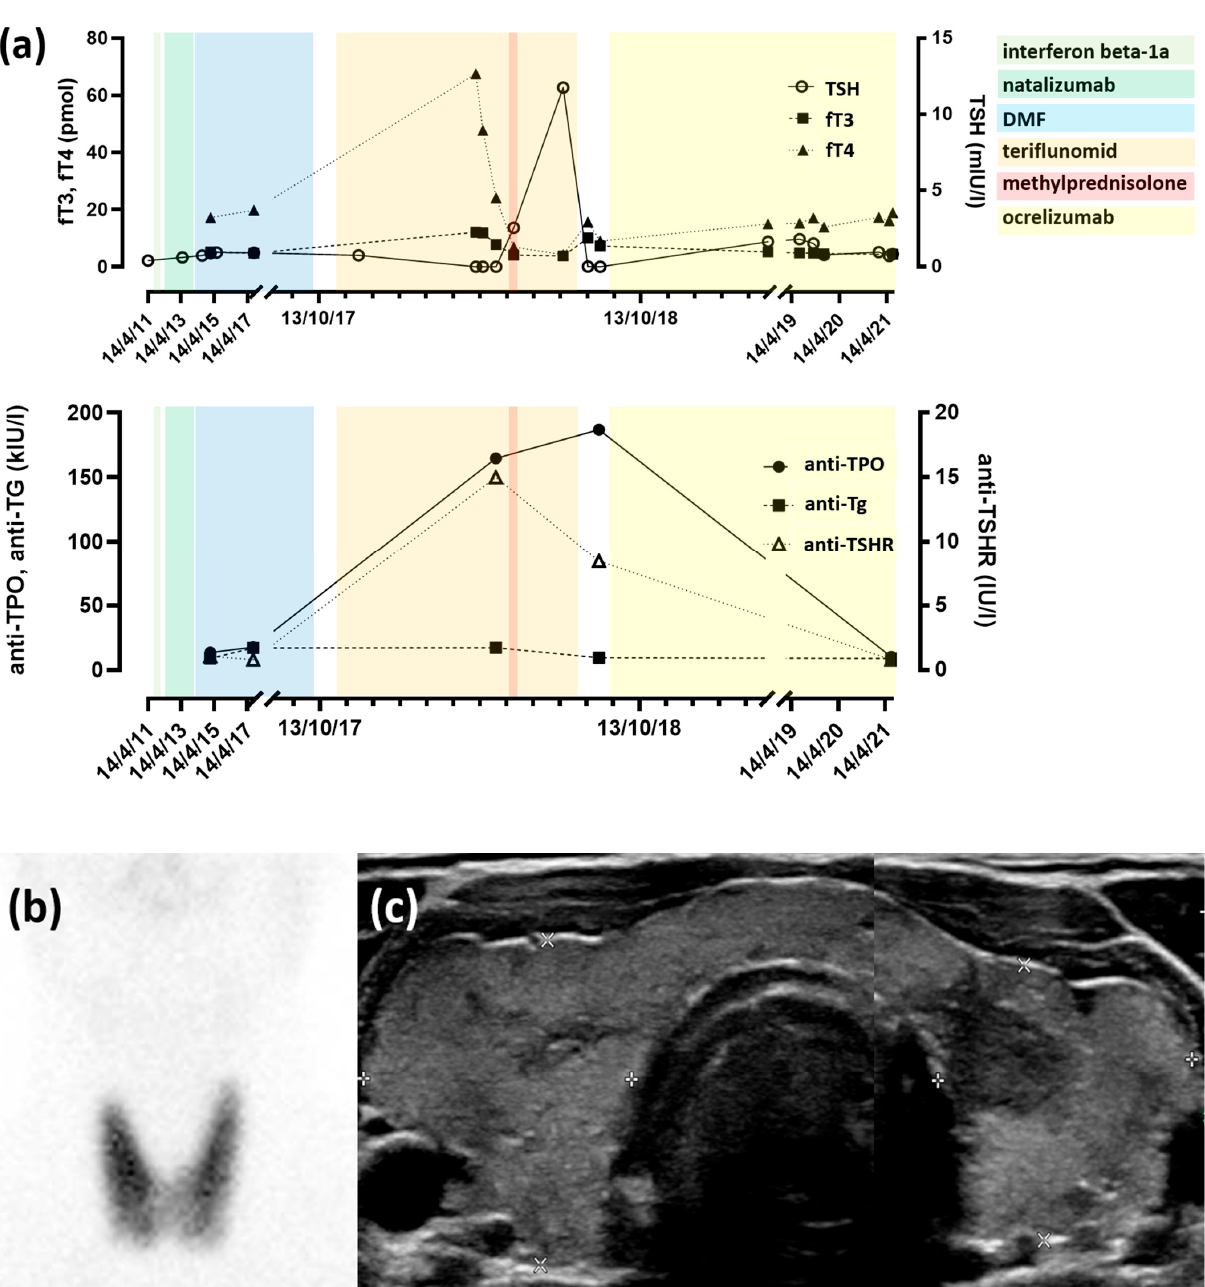
Figure 1. ( a ) Temporal evolution of thyroid function tests and thyroid autoantibody titers in the patient with GD. Treatments were as follows: beta-1a interferon, 44 mcg 3/week (22.06.2011–